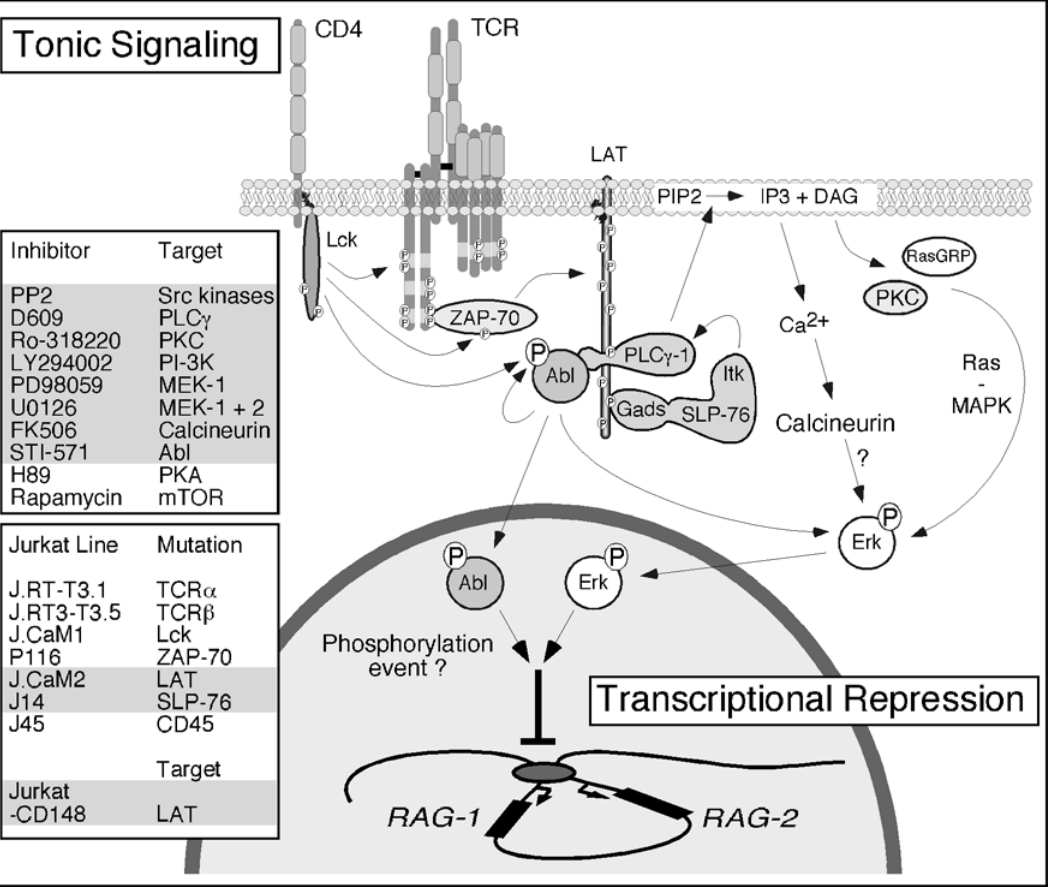
Figure 8. Model of the Constitutive Signaling Pathway That Provides a Basal Repression of RAG Gene Transcription Constitutive signaling in resting thymoytes and our model Jurkat T cell line represses RAG gene expression. Chemical inhibition of signaling molecules, genetic modifications, or induced expression of genes that resulted in elevated RAG expression are summarized in the gray-shaded boxes. The tonic signal and therefore normal expression of RAG genes rely strongly on signaling through the adapter LAT. The effects of basal phosphorylation of LAT are twofold: (1) recruitment and activation of PLC c generates low levels of second messengers that signal through calcium and Ras pathways, culminating in Erk kinase activity; and (2) phosphorylation of tyrosine residue 6 of LAT, likely establishing a LAT– PLC c –Abl complex, is required for low-level kinase activity of Abl. Abl and Erk kinase activities deliver unique repressive signals to control RAG gene expression. DOI: